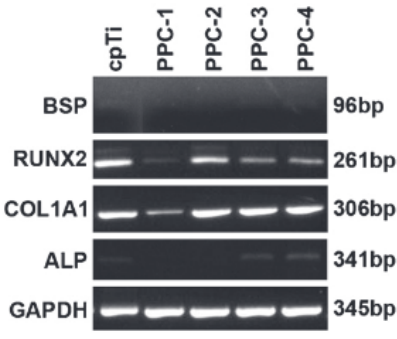
Figure 13. PCR demonstrated all of the constitutional genes, COL1A1, and GAPDH, were expressed by all of the cells. In addition, osteogenic genes and RUNX2 were also expressed to various extents by the cells on different biomaterial